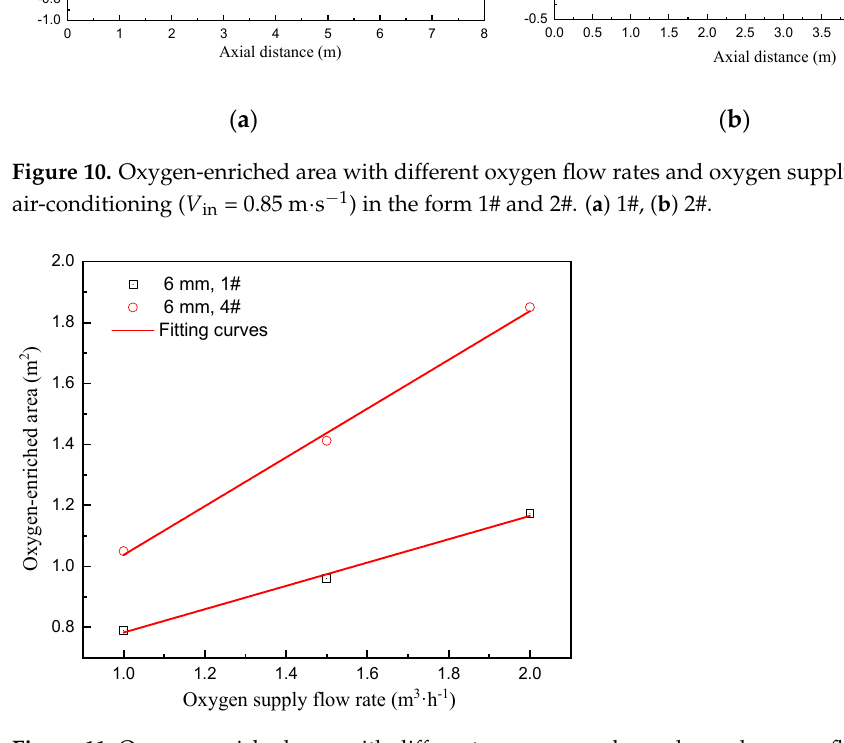
Figure 10. Oxygen-enriched area with different oxygen flow rates and oxygen supply modes un- der air-conditioning ( V in = 0.85 m·s − 1 ) in the form 1# and 2#. ( a ) 1#, ( b ) 2#.